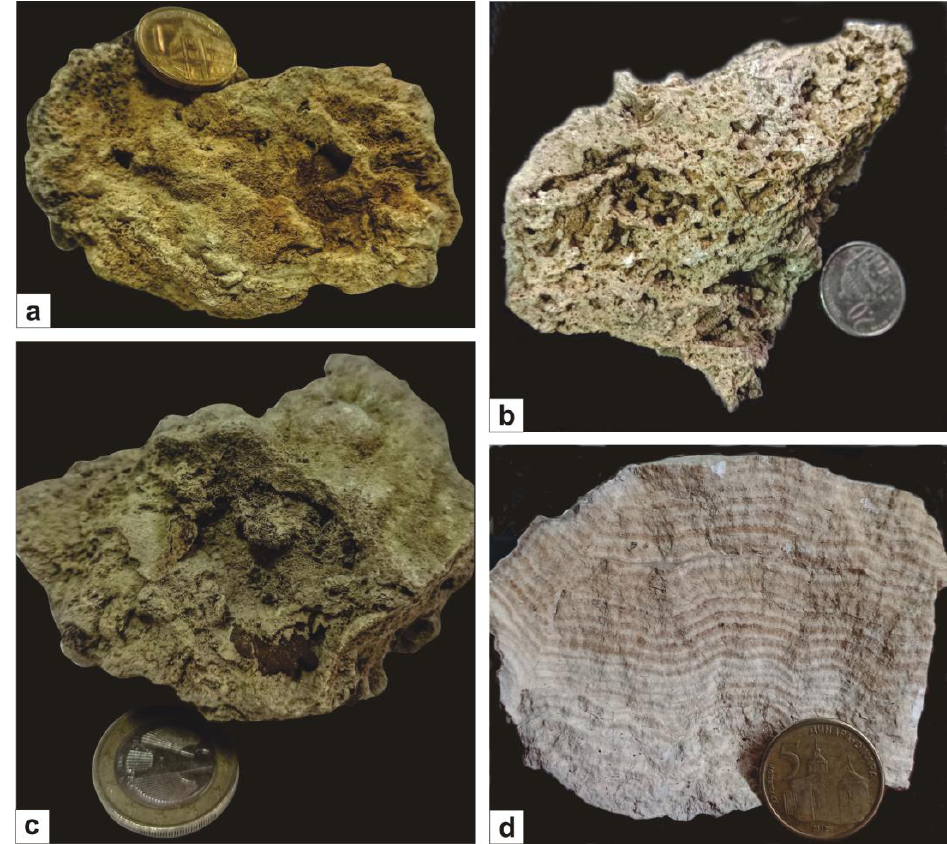
Figure 3. Samples of the most representative tufa samples. ( a ) Algal tufa; ( b ) Moss tufa; ( c ) Phytoclastic tufa; ( d ) Stromatolitic laminated tufa.